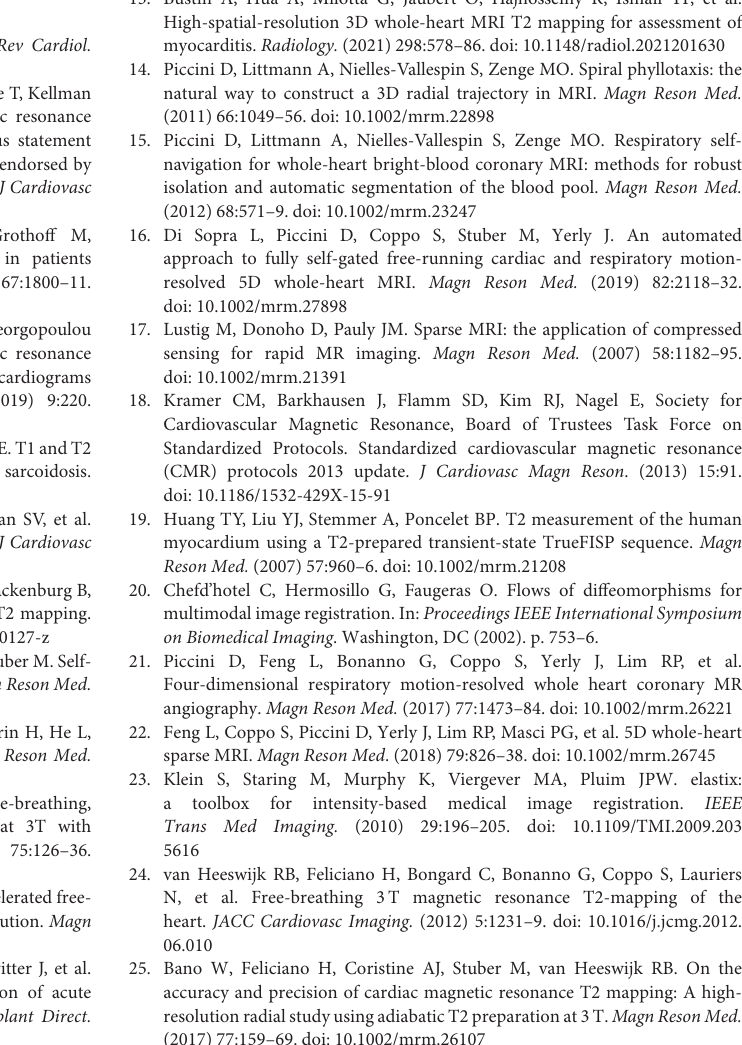
respectively, but this is balanced by respectively increased and decreased T 2 variation in the myocardium. Supplementary Figure 3 | A paired comparison of the visual quality scores as agreed by two experienced readers. The 3D T 2 maps have a much higher variation in quality than the 2D T 2 maps (7.2 ± 2.1 vs. 9.6 ± 0.4, P < 0.001), although it should be noted that the 2D T 2 maps were immediately re-acquired during the scanning sessions if they were visually of unsatisfactory quality. Supplementary Figure 4 | A Bloch equation simulation of the influence of the patient’s heart rate on the estimated T 2 value. Since sampling occurs every other heartbeat, T 1 relaxation will cause a gradual underestimation of the T 2 value with the increase of the heart rate. Supplementary Animated Figure 1 | An animation of the respiratory-resolved reconstruction of a source image with T 2 prep duration of 30ms in a patient. The breathing motion is well-resolved, and results in a non-rigid translation of the